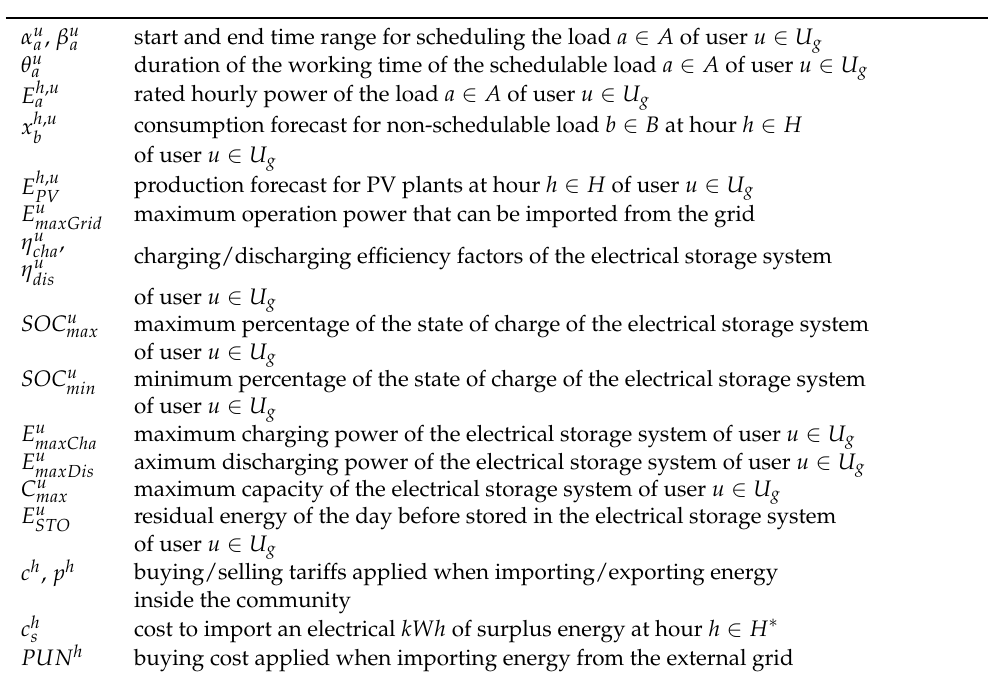
Table 3. Constants of the optimization